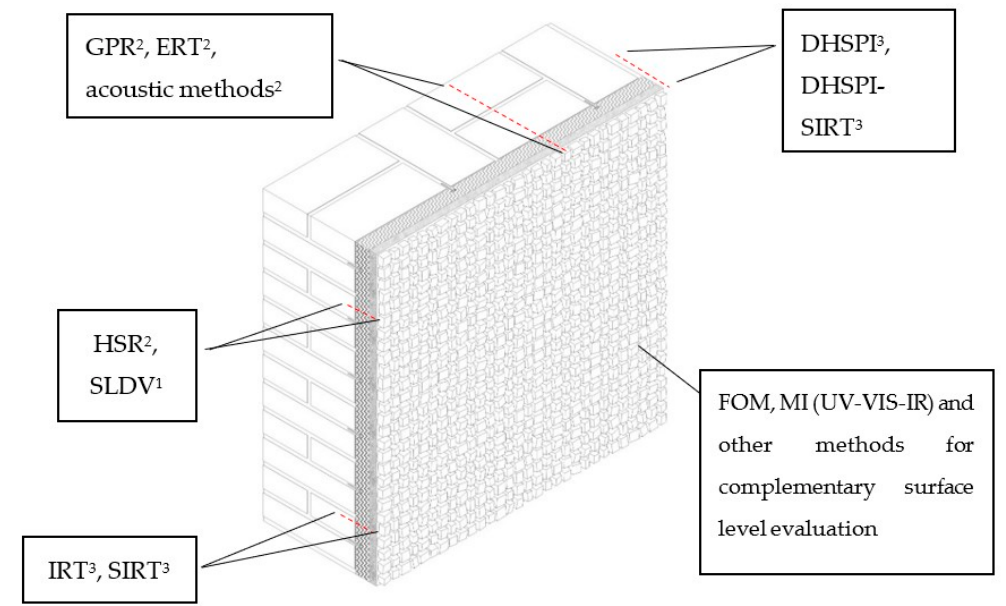
Figure 10. Complementarity of di ff erent techniques to a complex (depth-resolved) non-invasive study of wall mosaics, where: GPR—Ground Penetrating Radar, DHSPI—Digital Holographic Speckle Pattern Interferometry, FOM—Fiber Optics Microscopy, MI—Multispectral Imaging, IRT—Infrared Thermography, SIRT—Stimulated Infrared Thermography, SLDV—Scanning Laser Doppler Vibrometry; HSR—Holographic Subsurface Radar. 1 non-contact spot analysis; 2 method that requires